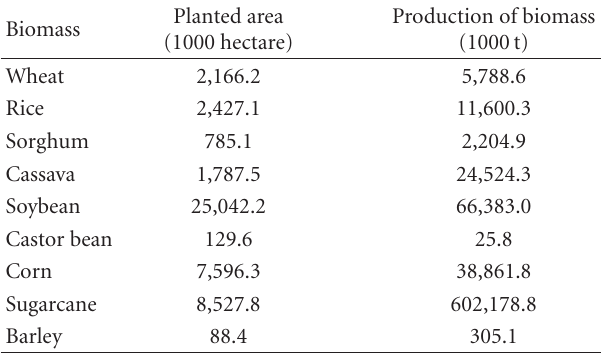
Table 1: Di ff erent feedstock cultivated in the Brazilian